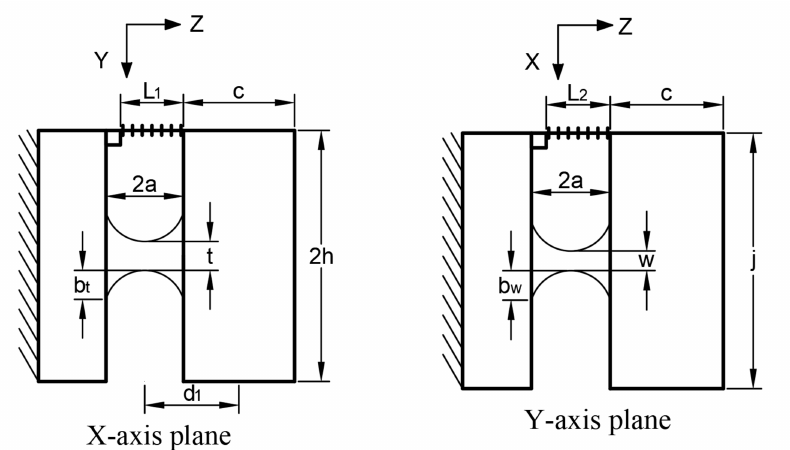
Figure 2. Simplified schematic of x-, y-directional